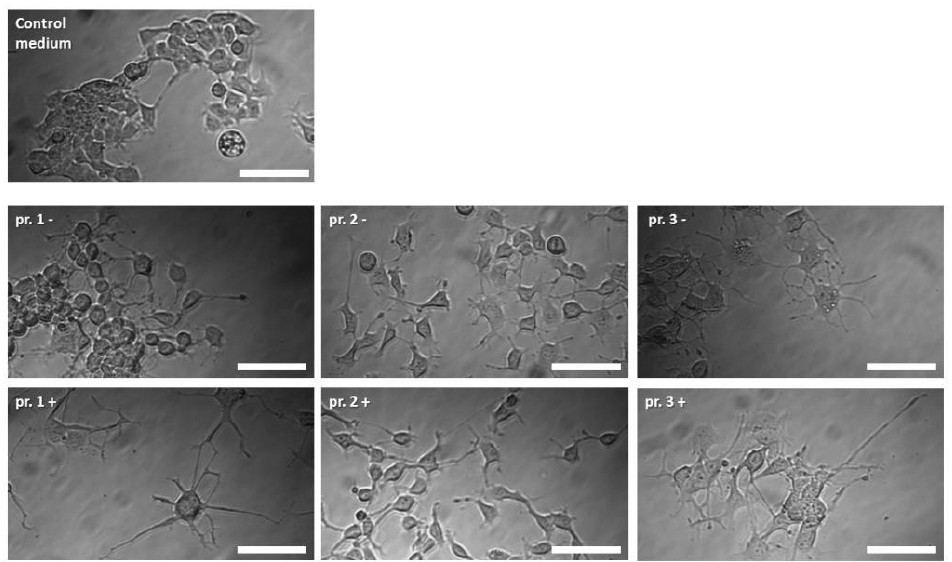
Figure 7. Morphological appearance of NG108-15 cells after cultivation with medium from Protocols 1, 2, and 3, with (+) and without ( − ) conditioning with predifferentiated ASCs. Scale bars are 100 µm.